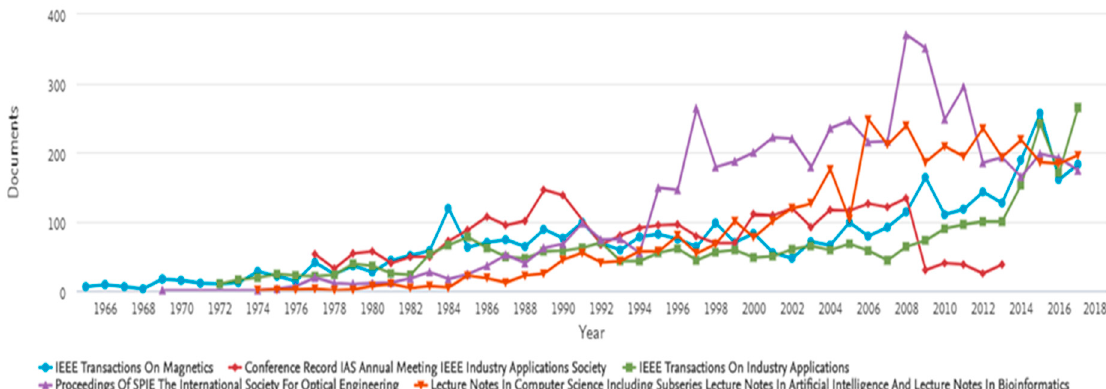
Figure 6. Analysis of the literature based on publishing sources (Source: Scopus & Web of Science).